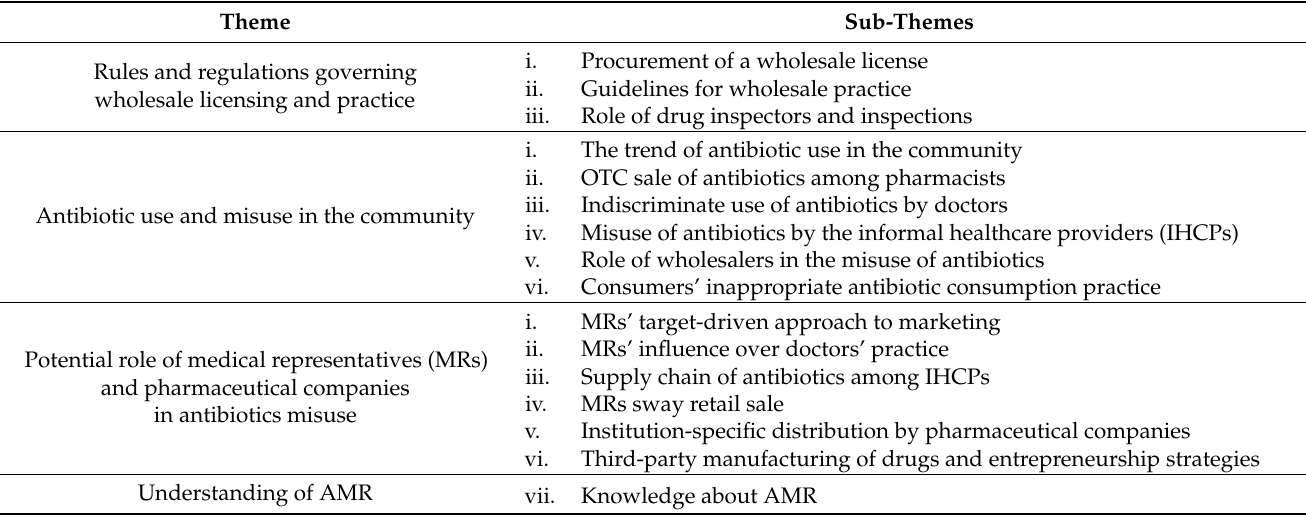
Table 1. Themes and sub-themes derived through systematic thematic analysis of in-depth interviews with